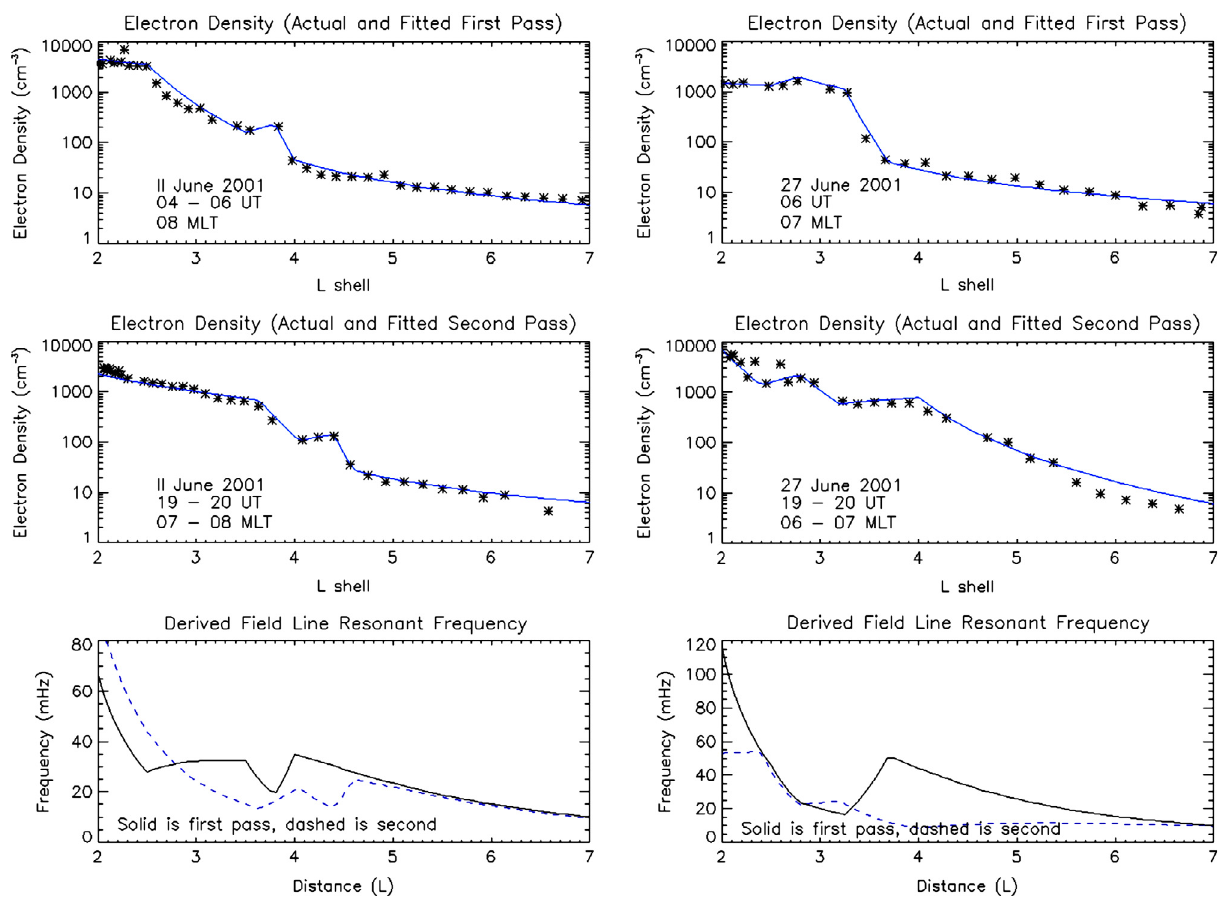
Fig. 8. (a) Top and middle: in situ electron density measurements (stars) and piecewise linear fits for two IMAGE satellite passes on 11 June 2001. Bottom: resultant inferred FLR profile for these two passes based on Alfvén speed derived from electron density measurements. (b) Same as Figure 8a except for 27 June 2001.